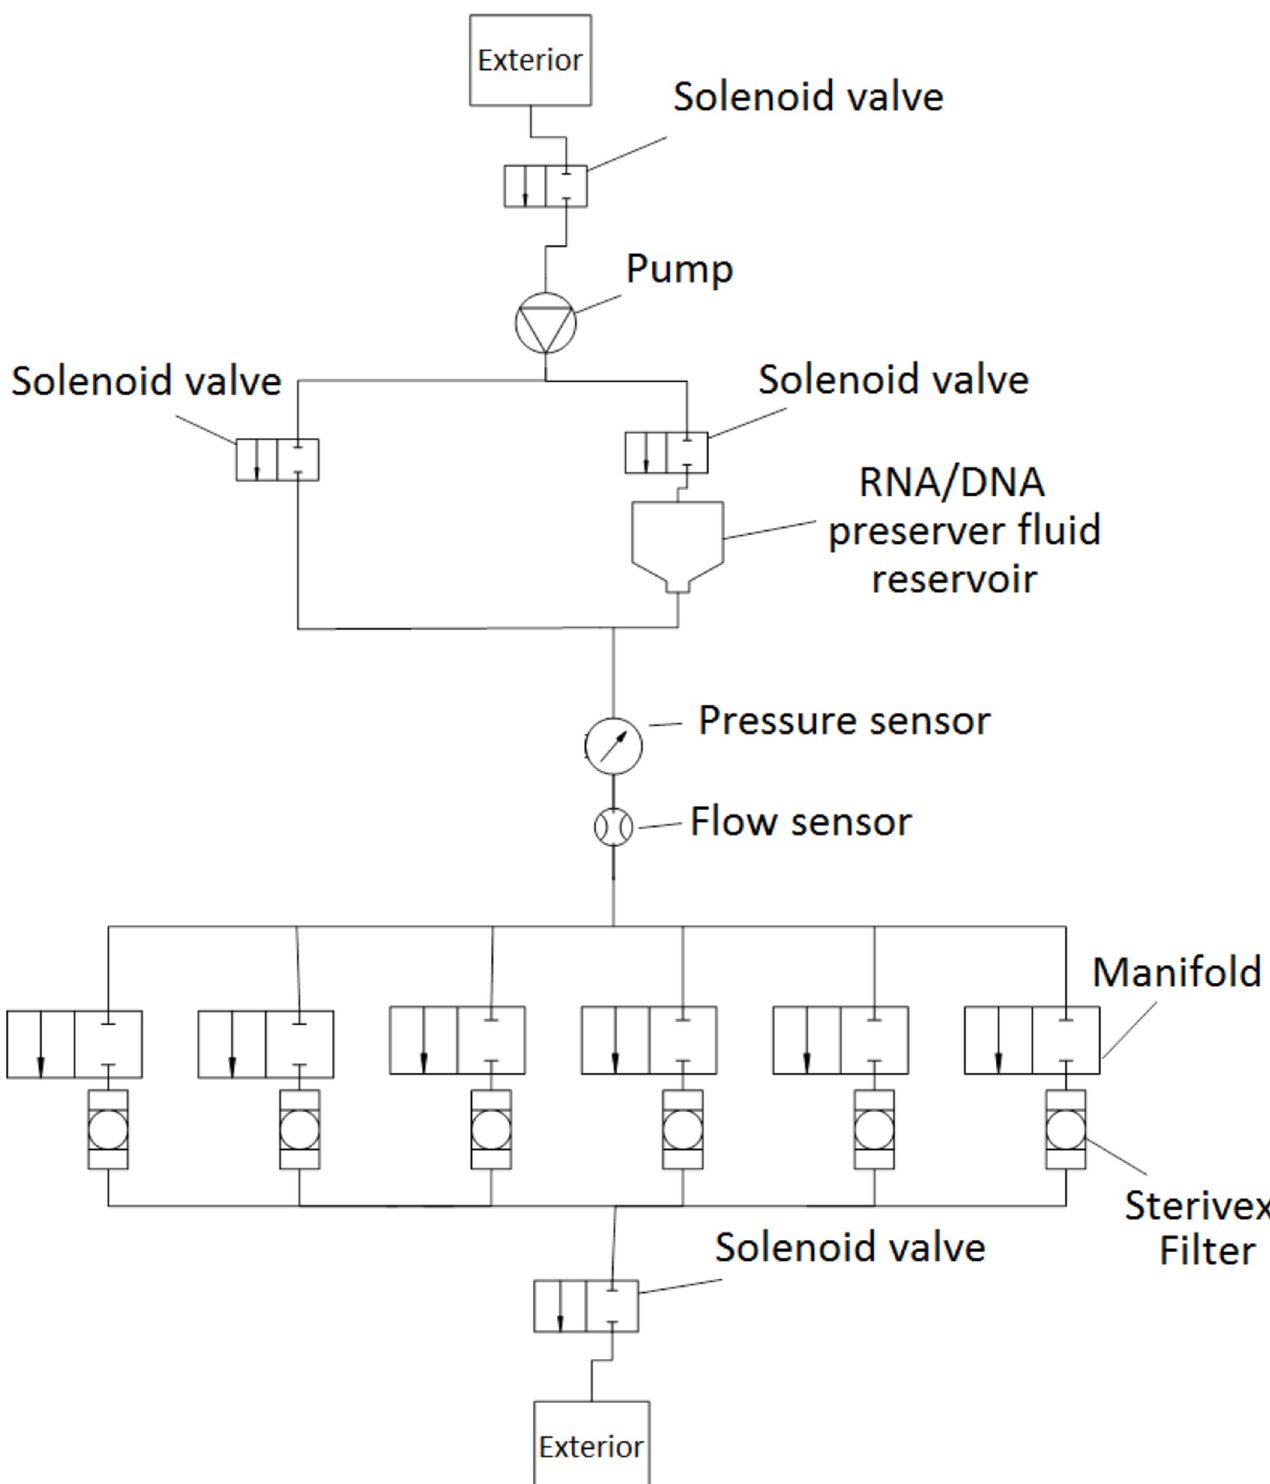
Fig 3. System hydraulic diagram. Water and RNAlater circuit with the solenoid valves that control which circuit is being used and the relative location of the pump and sensors.